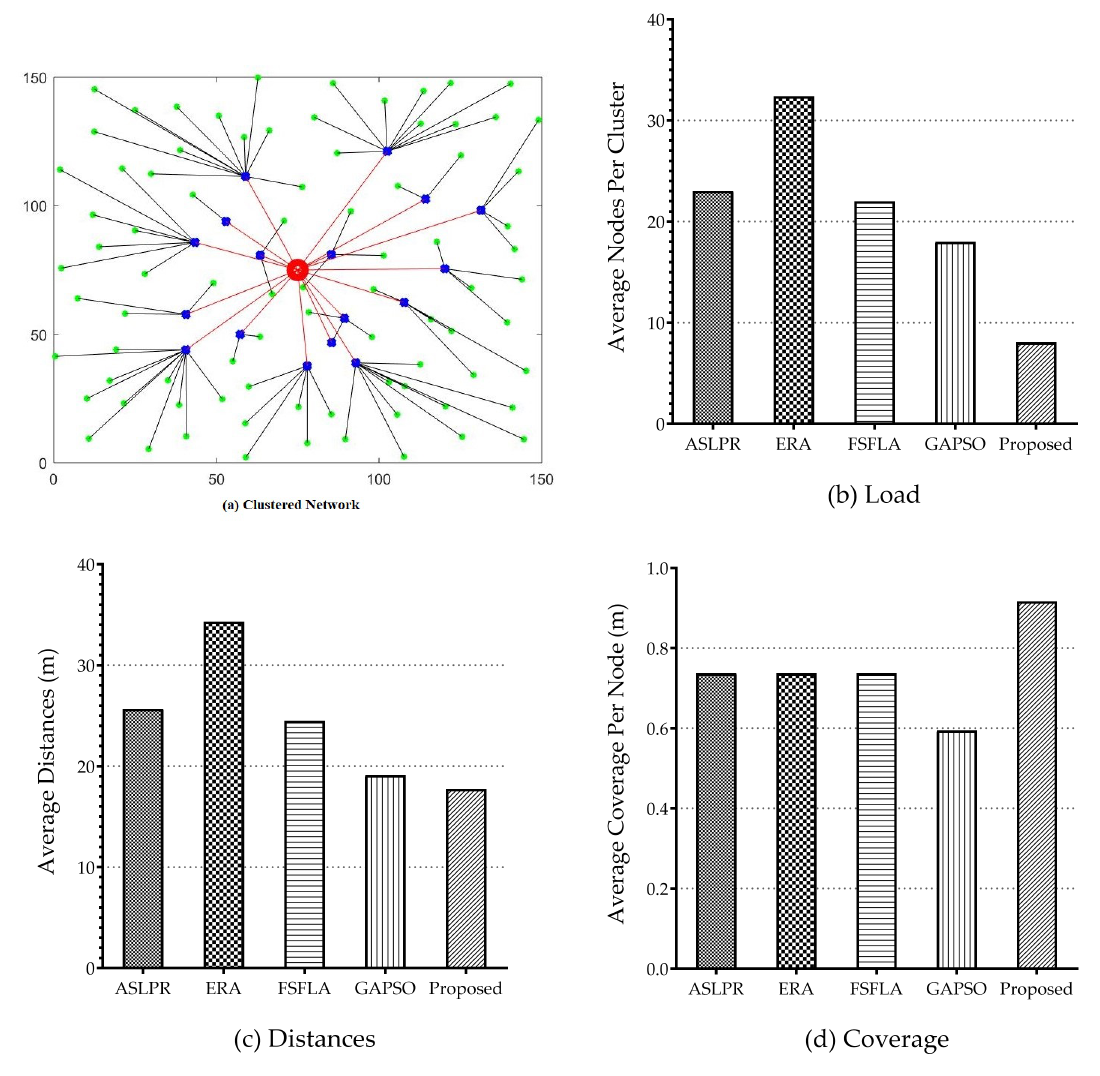
Figure 9. Performance of the proposed clustering algorithm. ( a ): clustered network and CH positions. ( b – d ): benchmarked performance in terms of load, distances, and coverage,